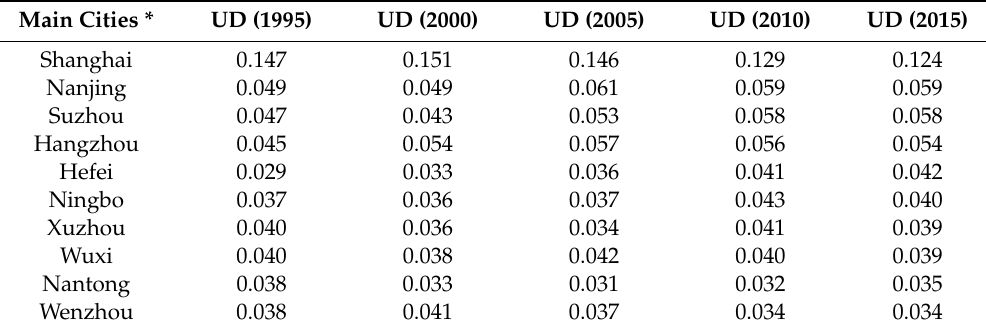
Table 1. Overall urbanization development (UD) values of major cities in the YRD region.